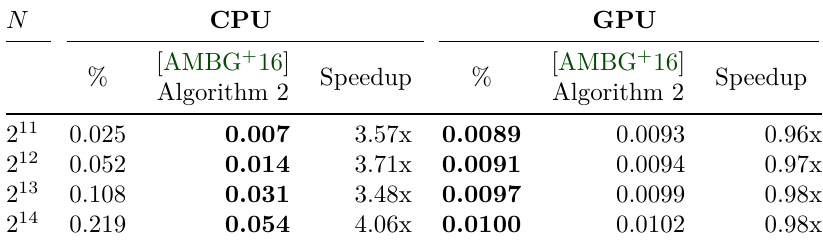
Table 1: Latency in (millisecond) of reducing N 62-bit integers modulo a 30-bit NFLlib prime p = 984481793 on Intel(R) Xeon(R) E5-2620 at 2.40 GHz with 24 cores and NVIDIA Tesla K80 card averaged over 10000